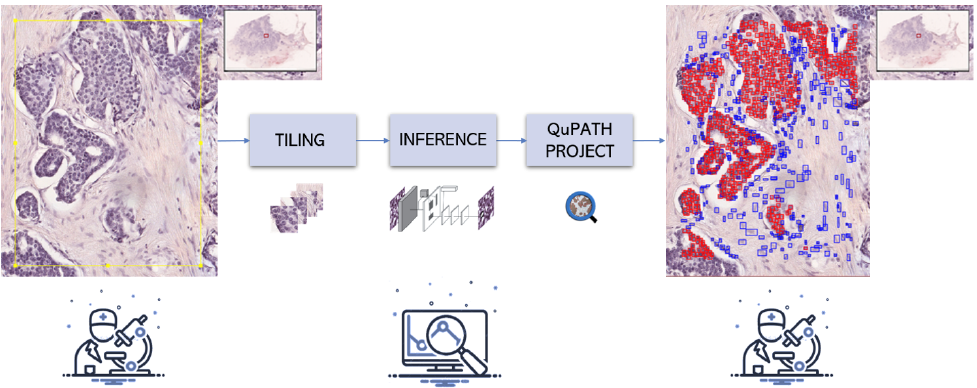
Figure 3. QuPath integration workflow. First, an ROI is selected by the operator. Then, the ROI is divided into smaller chunks that can be fed to a deep learning algorithm. Afterward, the results are reconstructed at the WSI-level and saved into a QuPath project to allow for visualization inside the QuPath